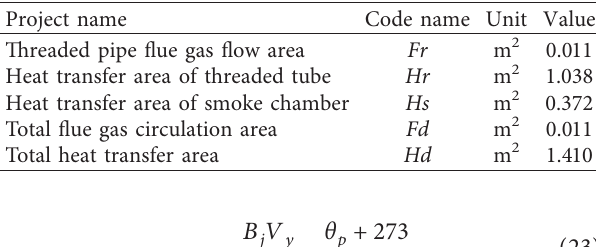
Table 6: Convection surface structure parameter